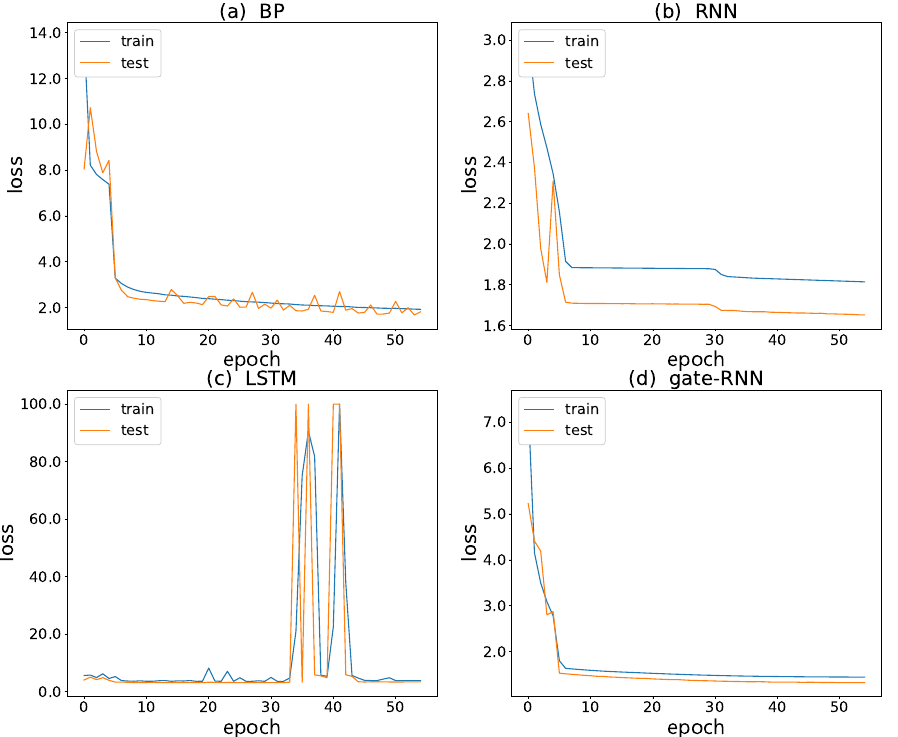
Figure 13. Neural networks’ losses on the train and test datasets for 20-min time scales: ( a ) loss of BPNN; ( b ) loss of RNN; ( c ) loss of LSTM; and ( d ) loss of gate-RNN. The blue line is the train loss curve and the orange line is the test loss curve.